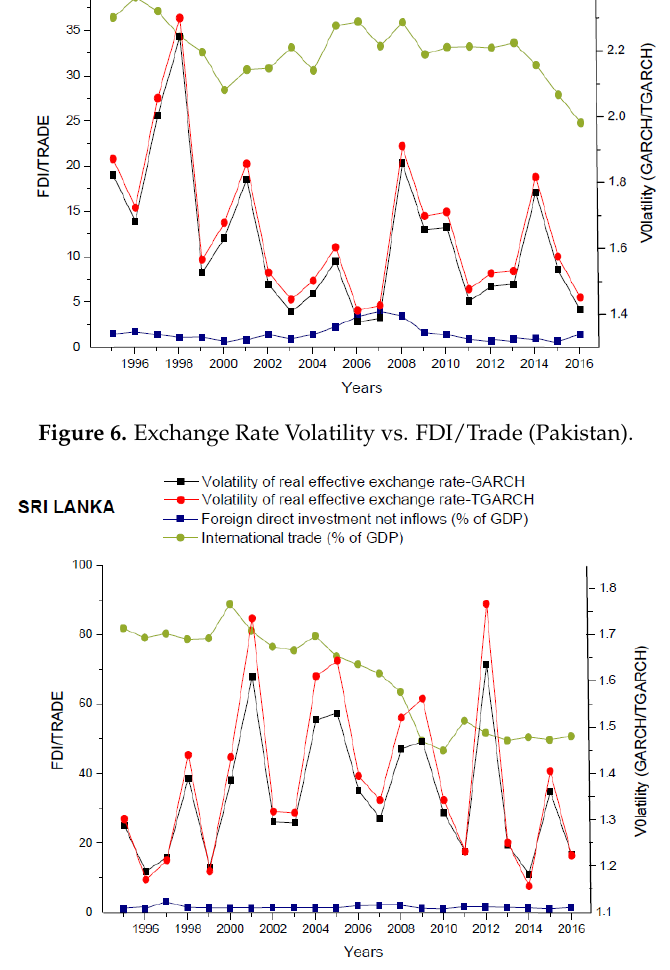
Figure 7. Exchange Rate Volatility vs. FDI/Trade (Sri Lanka).